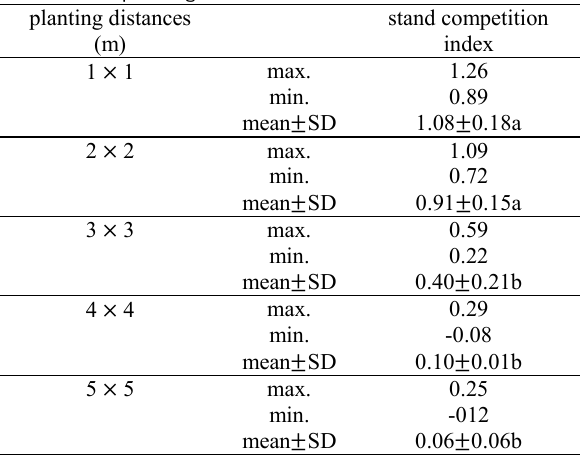
Table6. Stand competitive index analysis in variant between the five different planting distances